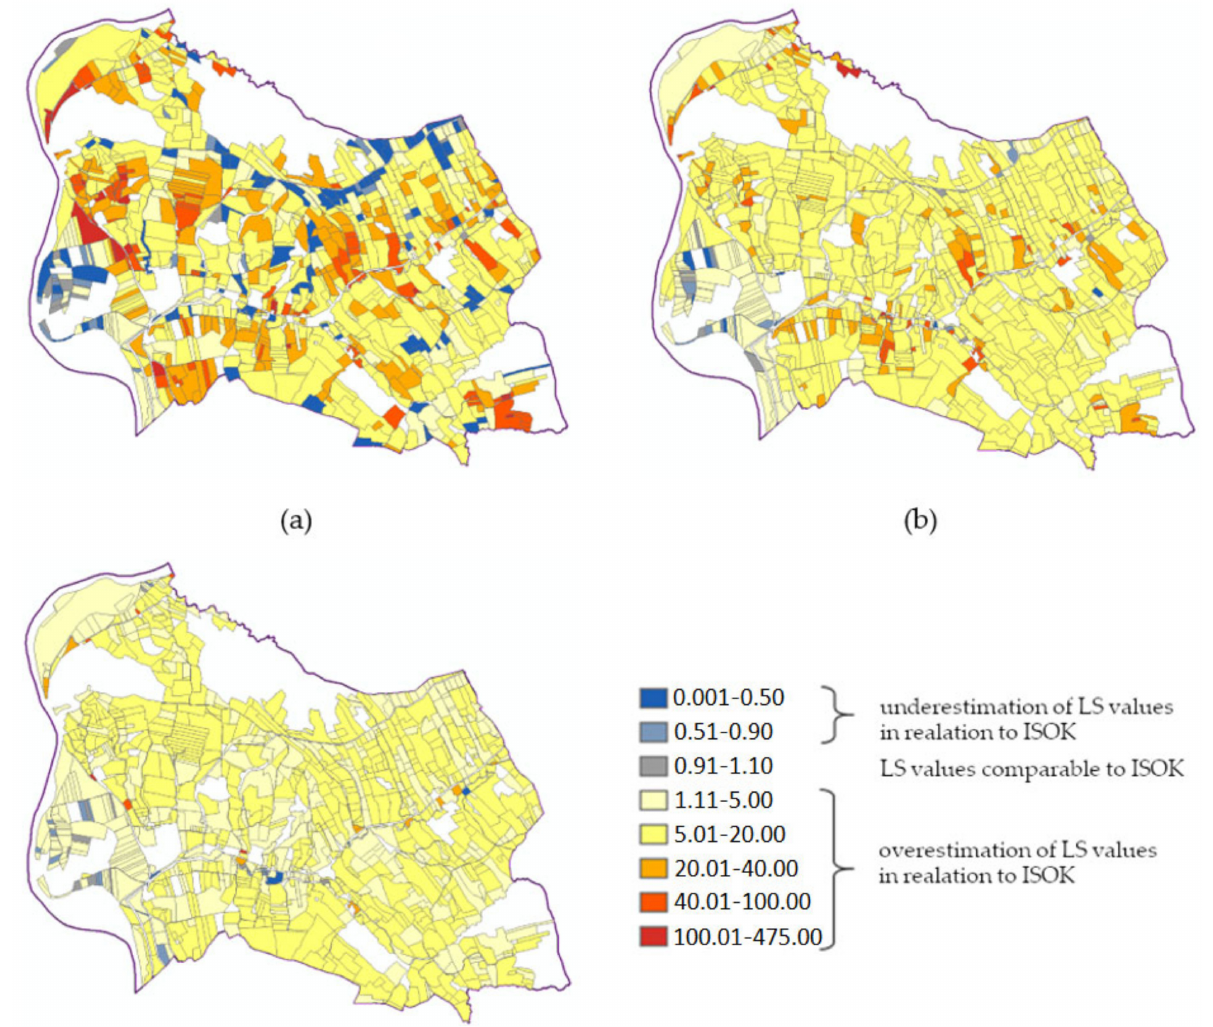
Figure A5. Comparison of the values of the variability index Wz for the sum of the total LS factor values in the plots used for agriculture obtained from the DTM SRTM ( a ), DTED2 ( b ) and LPIS ( c ) against ISOK for the Janowice research